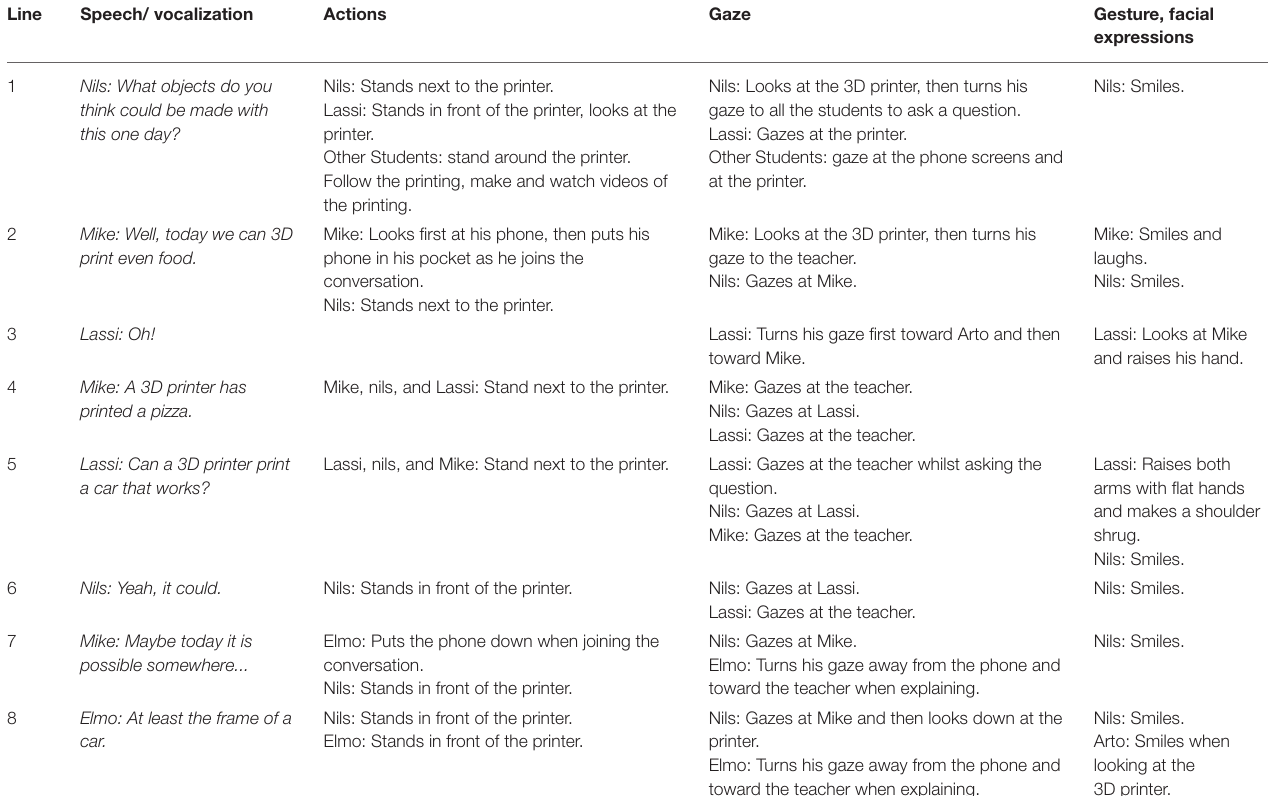
TABLE 6 | Imagining the future of 3D printing. Line Speech/ vocalization Actions Gaze Gesture, facial